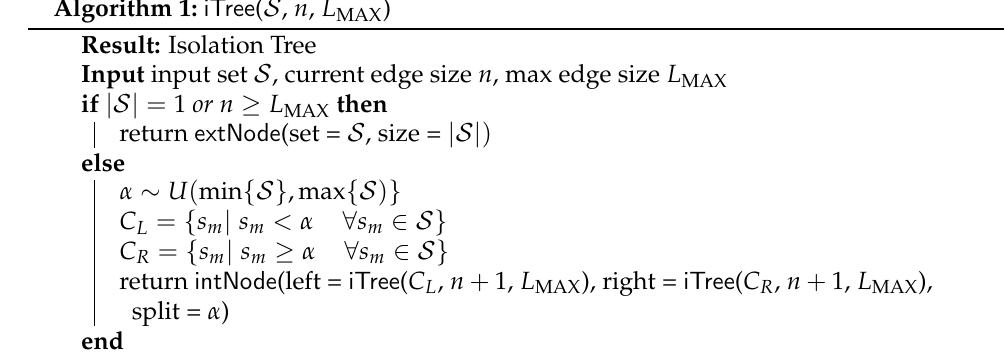
Algorithm 1: iTree ( S , n , L MAX